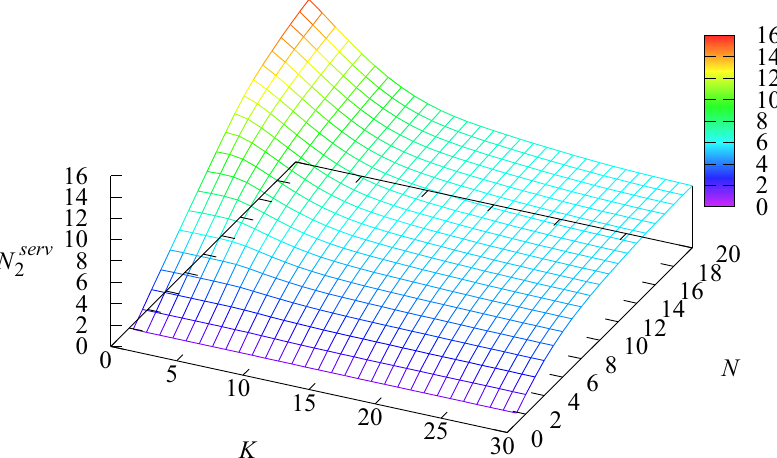
Figure 3. Dependence of the average number N serv N and K .